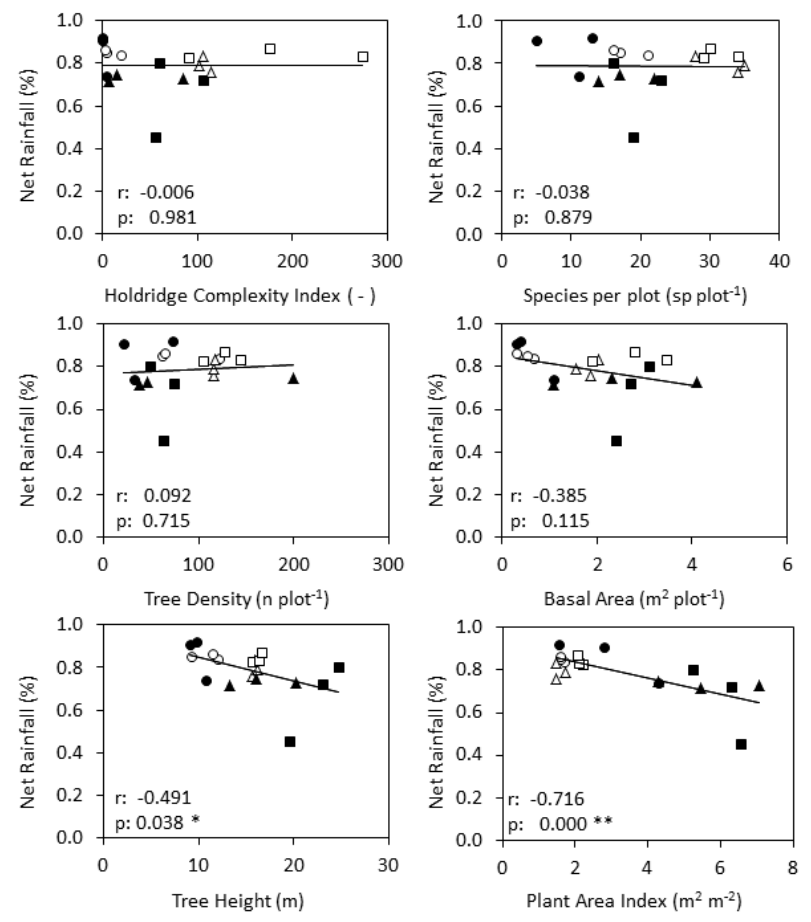
Figure 3. Net rainfall distribution in respect to forest structural parameters of the three successional stages (early: circles, intermediate: triangles, and late: squares) from Costa Rica (solid symbols) and Brazil (hollow symbols). Tendency solid lines include the 18 plots, while dashed tendency lines exclude the plot CR1L2 according with the document. The p-values (p) are significant at p < 0.05 (*) and p < 0.01 (**).